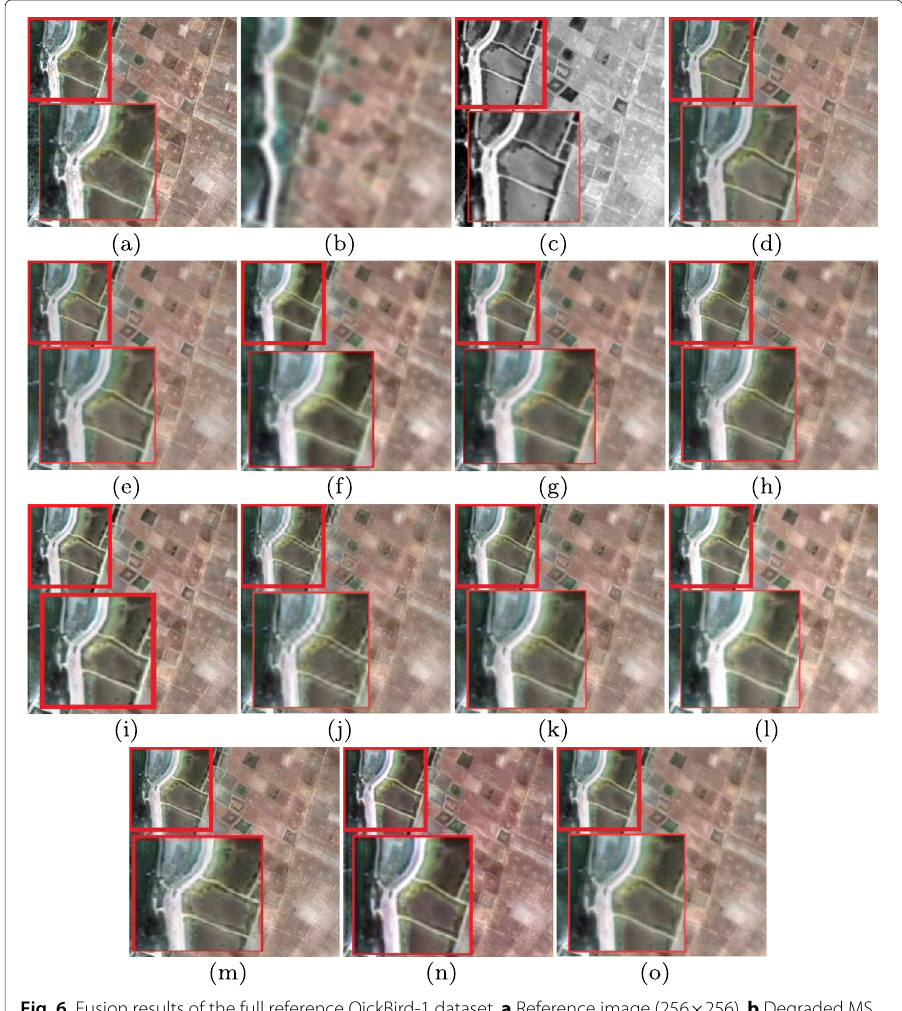
Fig. 6 Fusion results of the full reference QickBird-1 dataset. a Reference image (256 × 256). b Degraded MS image (64 × 64). c PAN image (256 × 256). d IHS method. e AIHS method. f PCA method. g BDSD method.